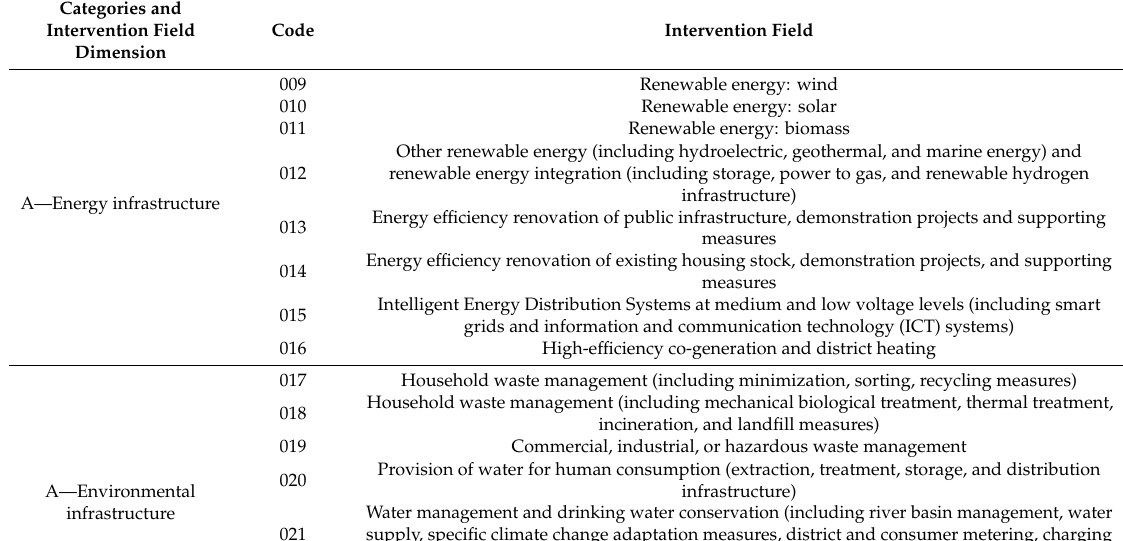
Table 2. Cohesion Policy funding categories and intervention fields for the period